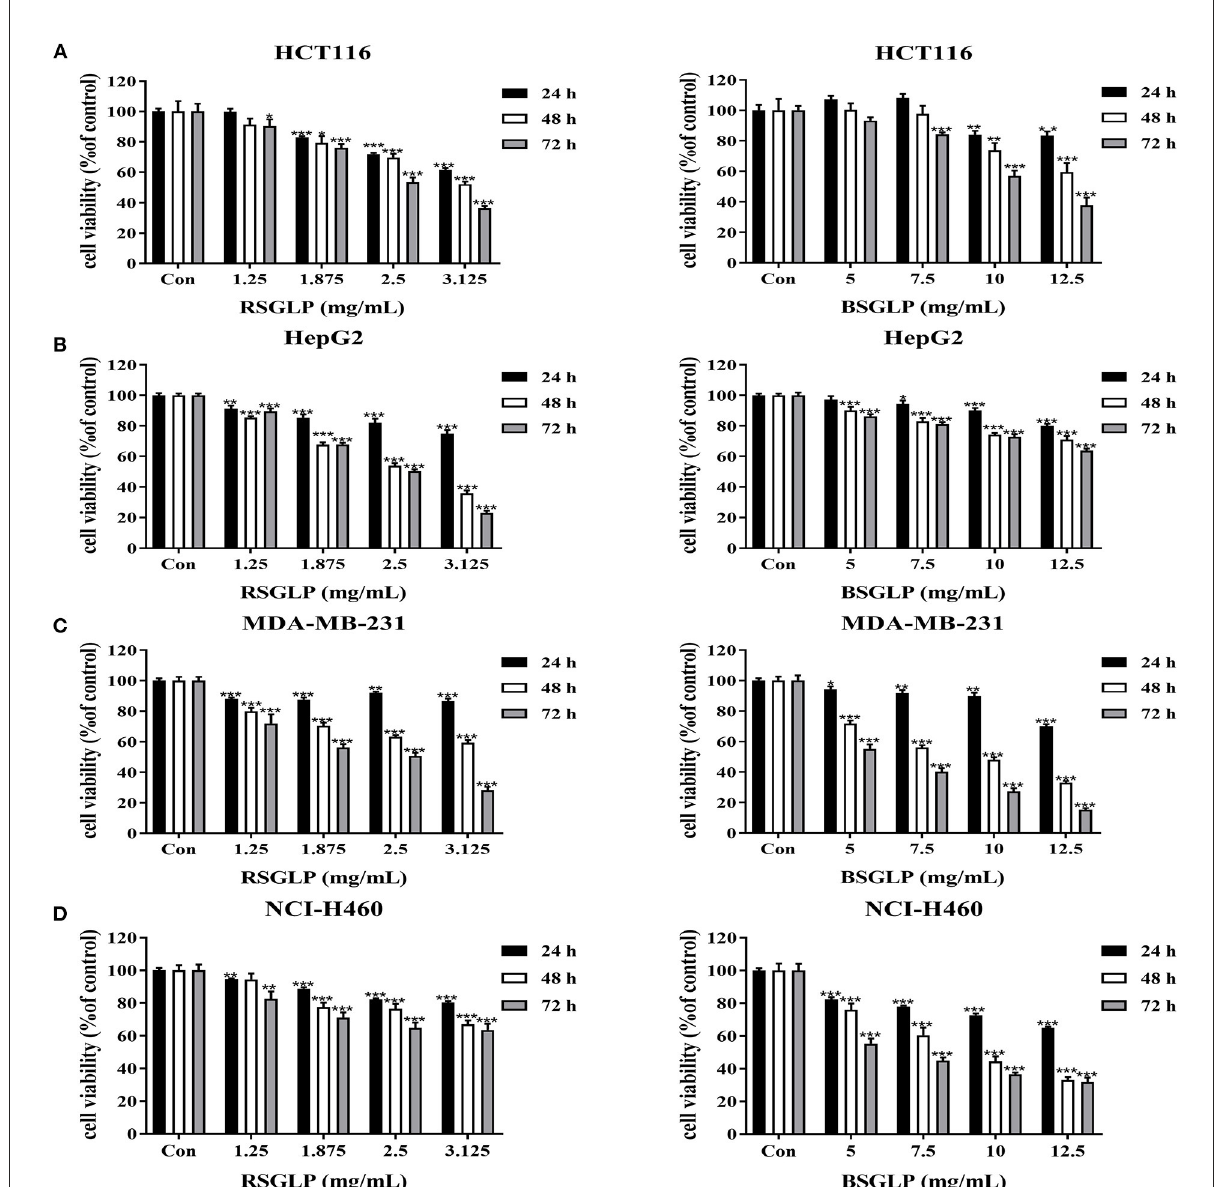
FIGURE2 Comparison of the cytotoxic effects of RSGLP and BSGLP in colon, liver, breast, and lung cancer cells as determined using MTT assay. (A) HCT116. (B) HepG2. (C) MDA-MB-231. (D) NCI-H460. Cells were treated with different concentrations of RSGLP (0, 1.25, 1.875, 2.5, and 3.125 mg/mL) and BSGLP (0, 5, 7.5, 10, and 12.5 mg/mL) for 24, 48, and 72h. Data are presented as mean ± SE from three independent experiments. * p < 0.05, ** p < 0.01, *** p < 0.001, compared with control